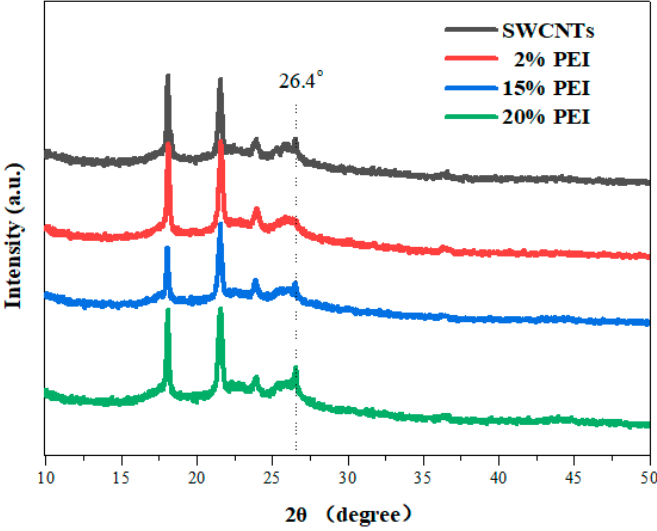
Figure 4. X-ray diffraction (XRD) patterns of pristine SWCNTs and SWCNT/PEI composites.